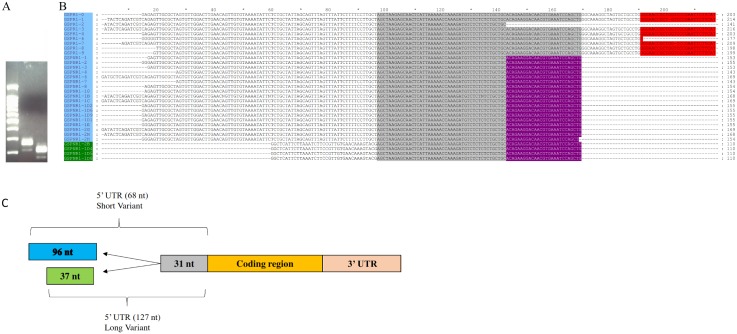
HbI produces two mRNA variants that differ in their 5’ ends.A) HbI 5’RACE products analyzed in a 2% electrophoresis gel: Lane 1) 100bp plus ladder from QIAGEN, 2) RACE product with GSP1R reverse primer, 3) RACE product with GSPN1R reverse primer. B) Multiple Sequence Alignment of HbI’s mRNA variants sequences using ClustalW and visualized in GeneDoc: The long variant sequences are highlighted in blue and the short variant sequences are highlighted in green. The bases were the GSP1R and GSPN1R primers annealed are highlighted in red and purple, respectively. C) Schematic representation of HbI mRNA variants.